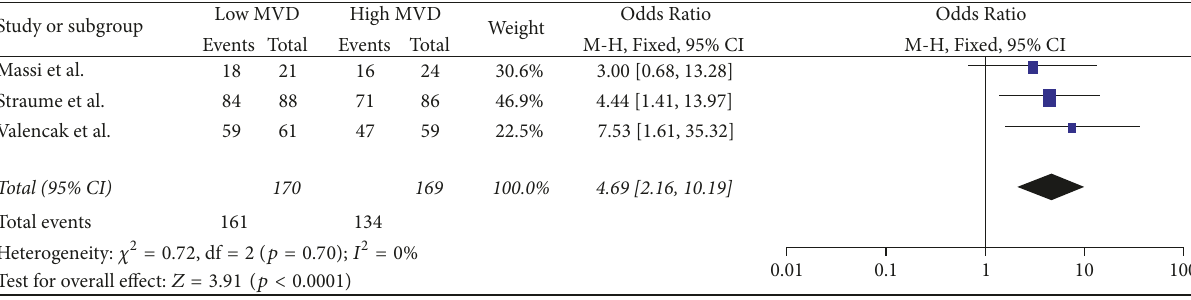
Figure 8: 12 months’ disease-free survival.